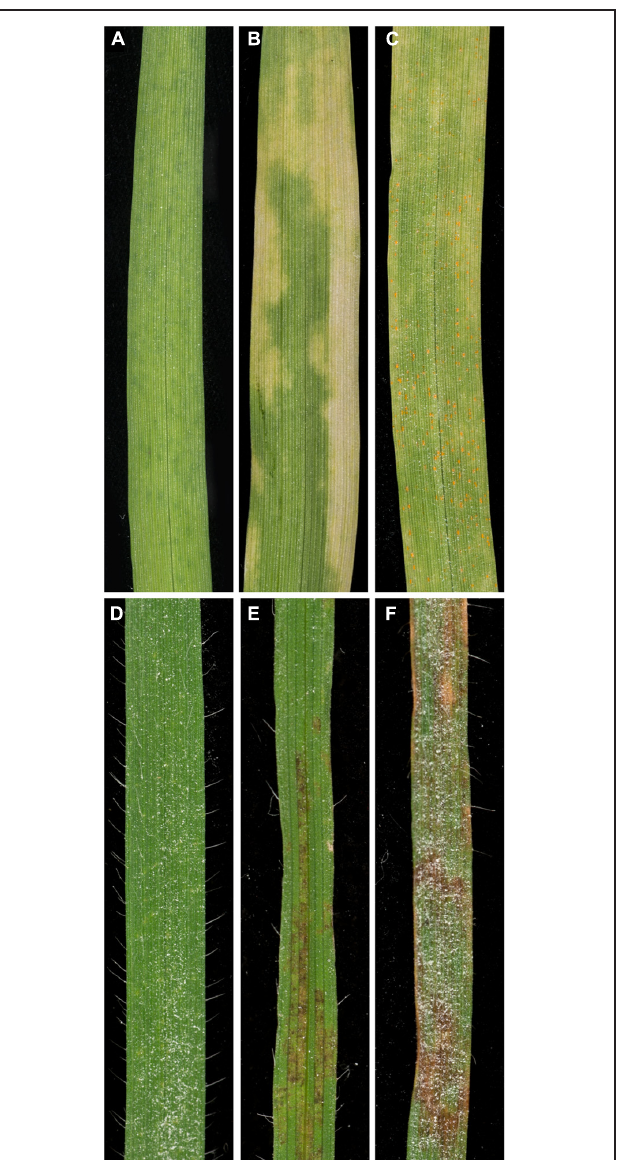
FIGURE 1 | Macroscopic phenotypes observed on barley and Brachypodium distachyon accessions challenged with Puccinia striiformis f. sp. tritici . Barley accessions challenged with P. striiformis f. sp. tritici were generally categorized into three groups: (A) immune (no observable macroscopic symptoms; accession Abed Binder 12), (B) chlorotic (accessions displaying varying degrees of chlorosis; accession Foster), and (C) compatible (pustules observed, indicative of life cycle completion; accession Manchuria). B. distachyon accessions challenged with P. striiformis f. sp. tritici displayed either (D) immunity (accession ABR6), (E) moderate leaf browning (accession Bd21), or (F) severe leaf browning (accession